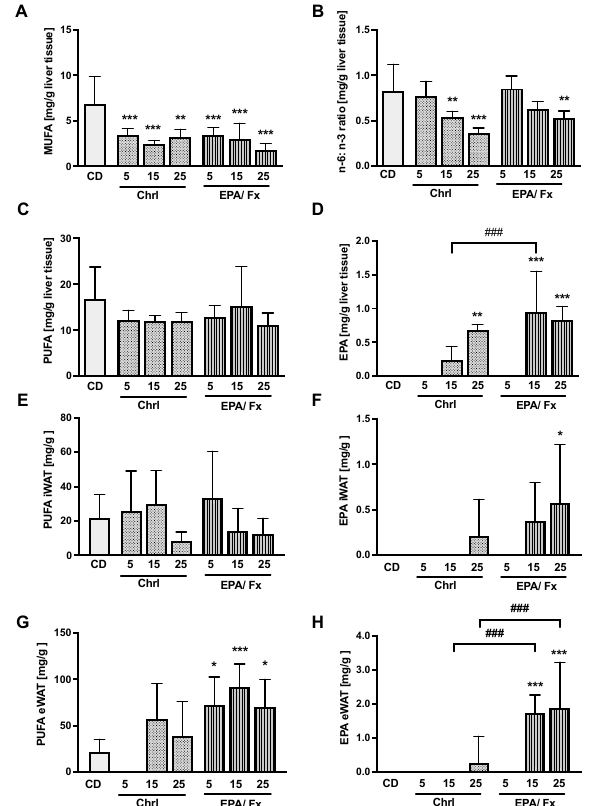
Figure 4. Fatty acids were measured by gas chromatography in the liver ( A – D ), subcutaneous WAT ( E , F ), and visceral WAT ( G , H ). MUFA amounts were lower in association with all microalgae diets ( A ), and the ratio of n-6-to-n-3 PUFA ( B ) decreased in association with higher supplementation of the two microalgae diets. PUFA content was increased in eWAT ( G ) in association with the EPA/Fx diets, and EPA content increased in all tissues with higher supplementation of the EPA/Fx diets and in the liver in association with the Chrl25 diet ( D , F , H ). Data are expressed as mean ± SD ( n = 8 per group). Statistics: * indicates difference relative to CD, and # indicates the difference between Chrl and EPA/Fx diets. * p < 0.05, ** p < 0.01, ***/ ### p < 0.001. Abbreviations: WAT, white adipose tissue; iWAT, inguinal (subcutaneous) WAT; eWAT; epididymal (visceral) WAT; see Table 1 and Figure 1 for other abbreviations.